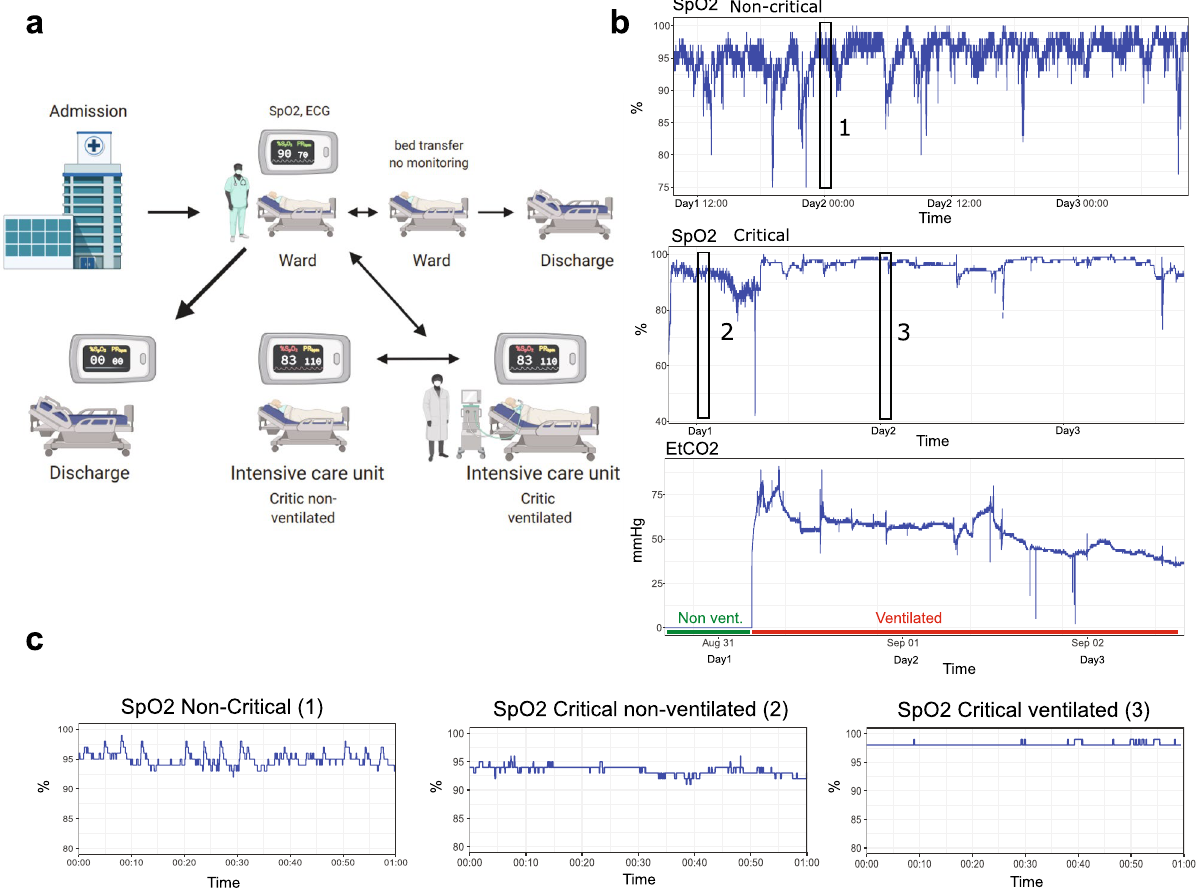
Figure 2. Patient in-hospital movement and examples of SpO2 signal in critical and non-critical cases. ( a ) Frequent in-hospital movement of ward monitored patients. For non-severe patients monitoring is only performed part time and a patient might be transferred or discharged depending on his health status. Image produced with BioRender.com. ( b ) SpO2 and EtCO2 signals of a non-critical and a critical COVID-19 patient with an initiation of ventilation. The transition between non-ventilated and ventilated state is clearly visible after an event of intense desaturation. Non-mechanically ventilated area is indicated in green and mechanically ventilated area is indicated in red, on the EtCO2 channel. ( c ) SpO2 signal of the same patients zoomed in on 1 h intervals, highlighted by black rectangles in panel ( b SpO2 distribution. The 95% confidence interval of continuous SpO2 measurements in non-critical COVID-19 patients was between 92 and 98% and in critical patients between 88 and 98%. The mean SpO2 was significantly lower among critical patients without support, compared to the non-critical patients ( p value < 0.05, Fig. 3A,C). The lower SpO2 range between 80 and 90% depicted a higher density in the critical group ( p value < 0.01). The non-critical group showed a narrower peak of density centered around 96% SpO2. A similar, although milder trend was observed in the critical versus non-critical patients under oxygen therapy (Fig. 3B,C). The median oxygen flow rate used for the oxygen support was significantly higher in critical patients ( p value < 0.001, 3B). The use of mechanical ventilation reduced the density of low SpO2 (80–90%) to a level closer to that seen in non-critical patients. On the other hand, critically ill patients who were mechanically ven- tilated or on oxygen support depicted a higher density of SpO2 level between 97 and 100% compared to critical non ventilated and non-critical patients. The SpO2 density per patient in each group revealed a variety of SpO2 patterns (3C), notably in non-critical and critical patients without support. In addition, this analysis identified a sub-group of critical patients on oxygen support that did not respond well to the therapy. Desaturation analysis. Overall, the absolute threshold of 93% was the most discriminating between criti- cal and non-critical groups (Fig. 4A), with p value < 0.001 and fold-change (FC) of 1.6 for no support and p value < 0.05 and 2.9 FC under oxygen support. A relative threshold of 3% SpO2 was able to discriminate critical from non-critical patients without support ( p value < 0.001). Next, for the optimal definition (93% absolute), we compared the distribution of area, depth, and desaturation duration between the critical and the non-critical groups with or without oxygen support (Fig. 4B, Fig. S2). Interestingly, the non-critical group depicted more desaturations per hour compared to the critical groups ( p value < 0.05, FC 1.8). This difference was abolished by oxygen support (non-significant, NS). Similarly, the depth and the "desat. time" (time between the beginning and